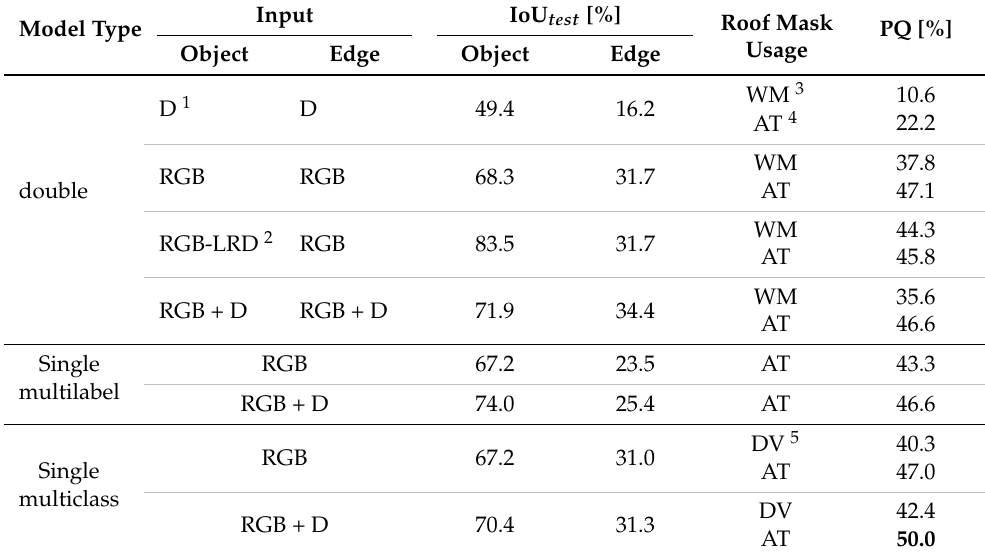
Table 3. Influence of the model type and input sources on panoptic quality (PQ). Model